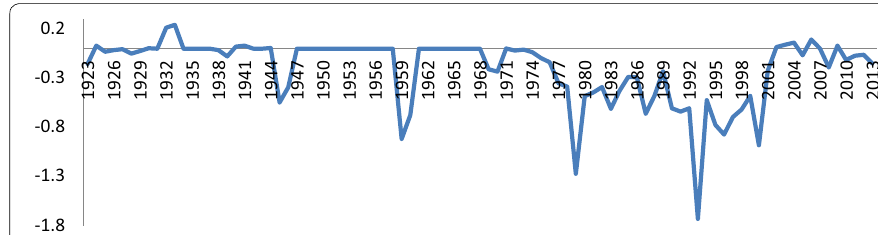
Fig. 3 Change rate in the lira (annual rate, 1923–2013). Source : Author’s calculation. The change rates in the lira were derived from TurkStat (Statistical indicators 1923–2013)